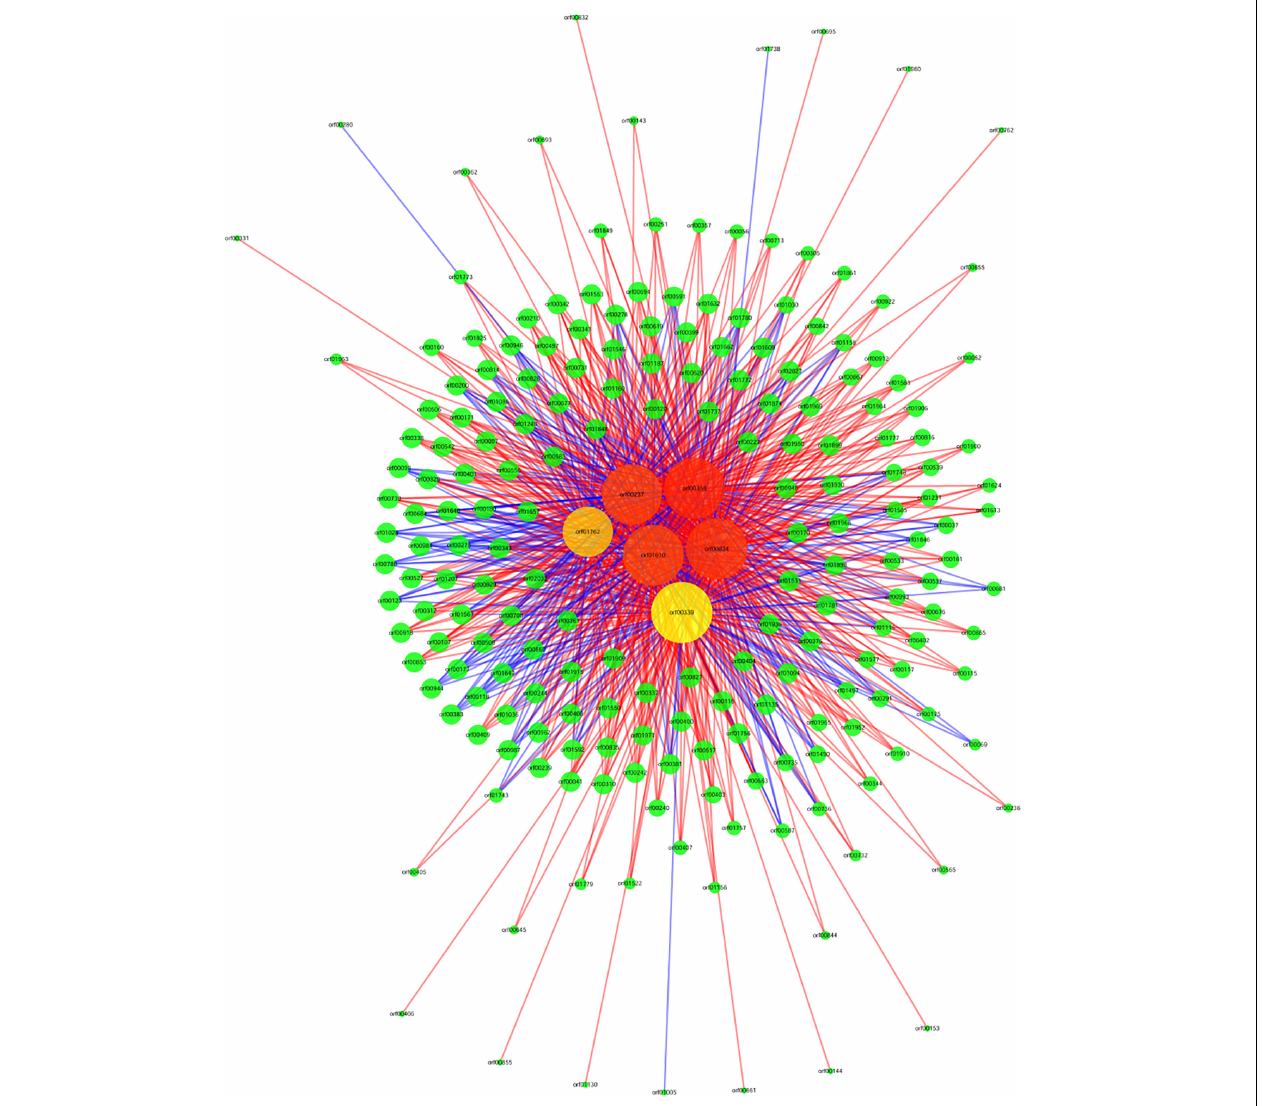
FIGURE 2 | Gene co-expression network. Genes from O. oeni SD-2a after acid shock at 1 h and 0 h. Cycle nodes represent genes, the size of nodes represents the power of the interrelation among the nodes, and the edges between two nodes represent the interactions between genes. The more edges of a gene indicate that more genes connect to it, indicating it has a more central role within the network. A straight line represents a mutual relationship, red indicates that the correlation coefficient is positive, and blue indicates that the correlation coefficient is negative.